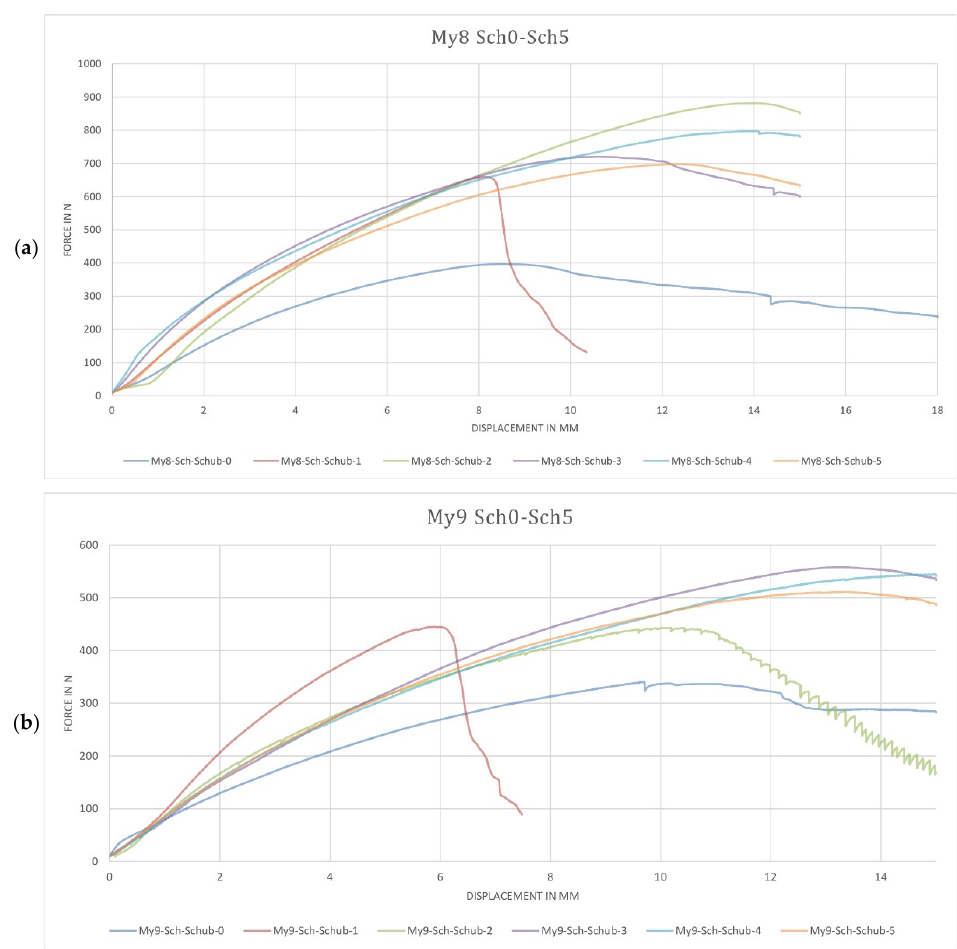
Figure 5. Diagrams showing the recorded force–displacement curves of conducted tests: ( a )